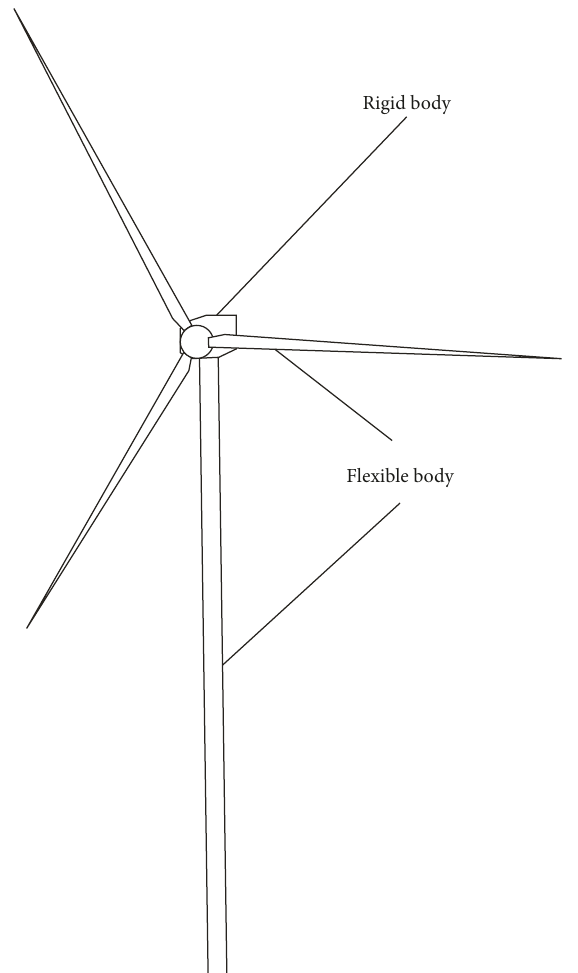
Figure 1: . Three-dimensional model of a rigid-flexible coupling system for a 5 MW wind